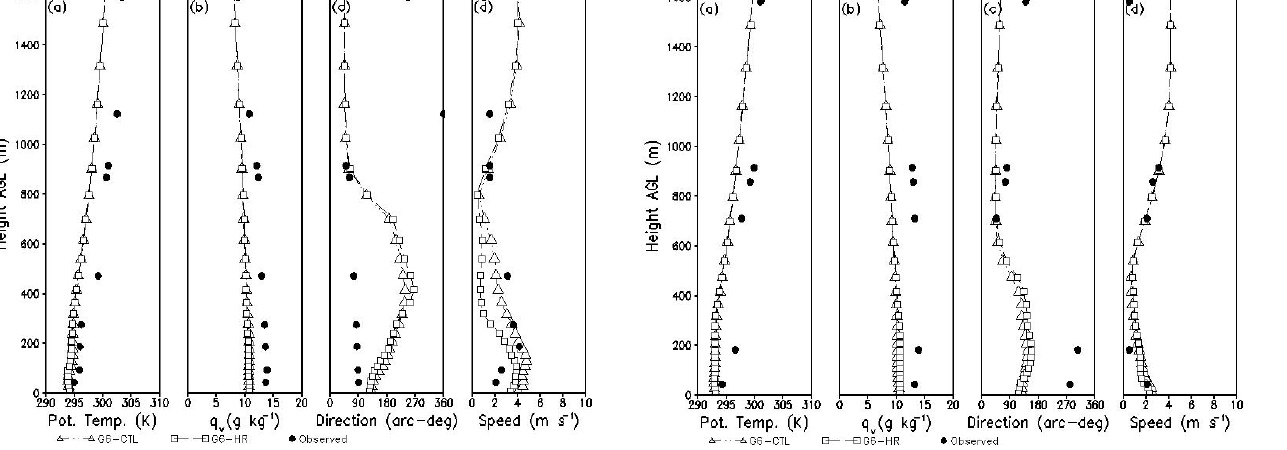
Figure 14. Vertical data profiles of (a) θ (K), (b) q v (gkg − 1 ) , (c) wind direction (arc-deg) and (d) speed (ms − 1 ) observed (closed circle) and simulated by G6 of the CTL (open triangle) and HR (open square) runs for 12:00UTC 7 September 2007 at SBGL upper-air weather